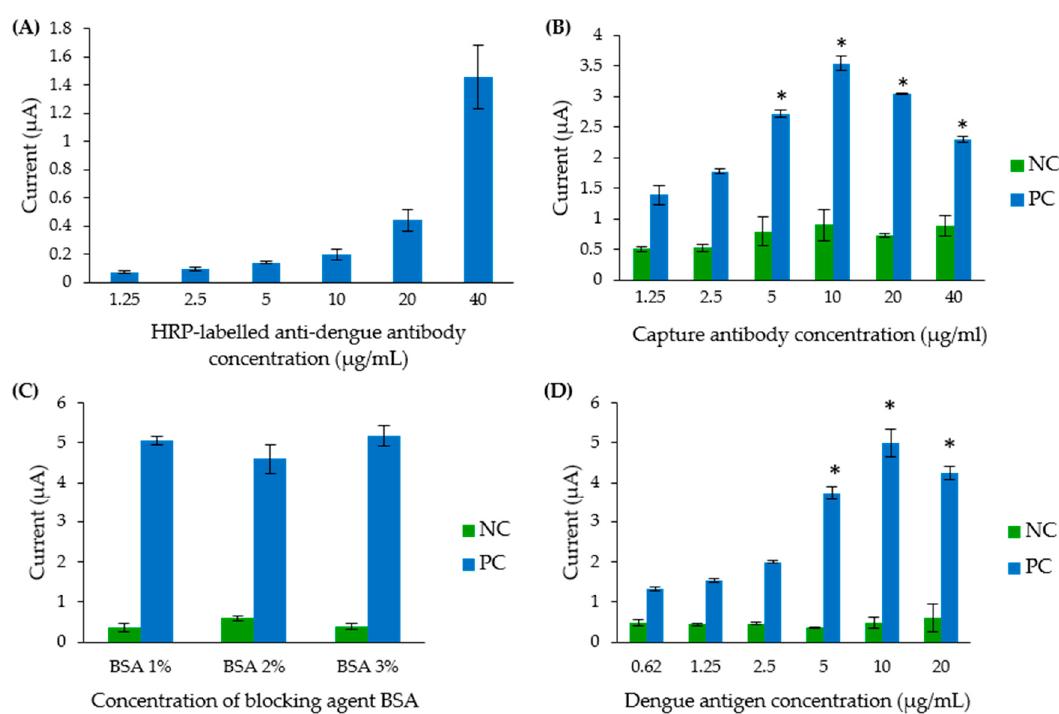
Figure 4. Optimisation of the concentration of various assay reagents. ( A ) Optimisation of the detection antibody concentration. ( B ) Optimisation of the goat anti-human IgM antibody. ( C ) Optimisation of the BSA concentration for blocking the electrode’s surface. ( D ) Optimisation of the dengue antigen concentration. NC: negative control (consisting of a dengue IgM negative serum pool), PC: positive control (consisting of a dengue IgM positive serum pool). * Indicates statistically significant current signals.